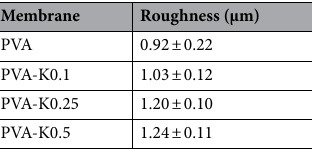
Table 1. Roughness of PVA hydrogel membrane and PVA/Kaolin composite hydrogel membranes. Values are presented as means ±